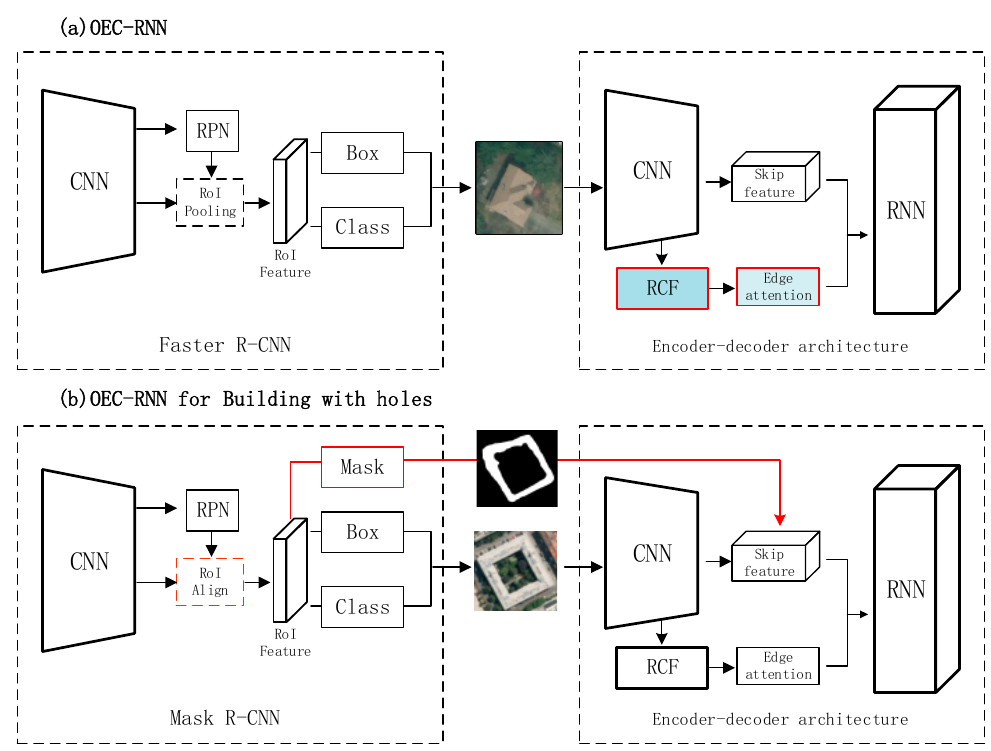
Figure 3. The network of OEC-RNN and OEC-RNN for buildings with holes. ( a ) Network structure of OEC-RNN. ( b ) Network structure of OEC-RNN for buildings with holes.